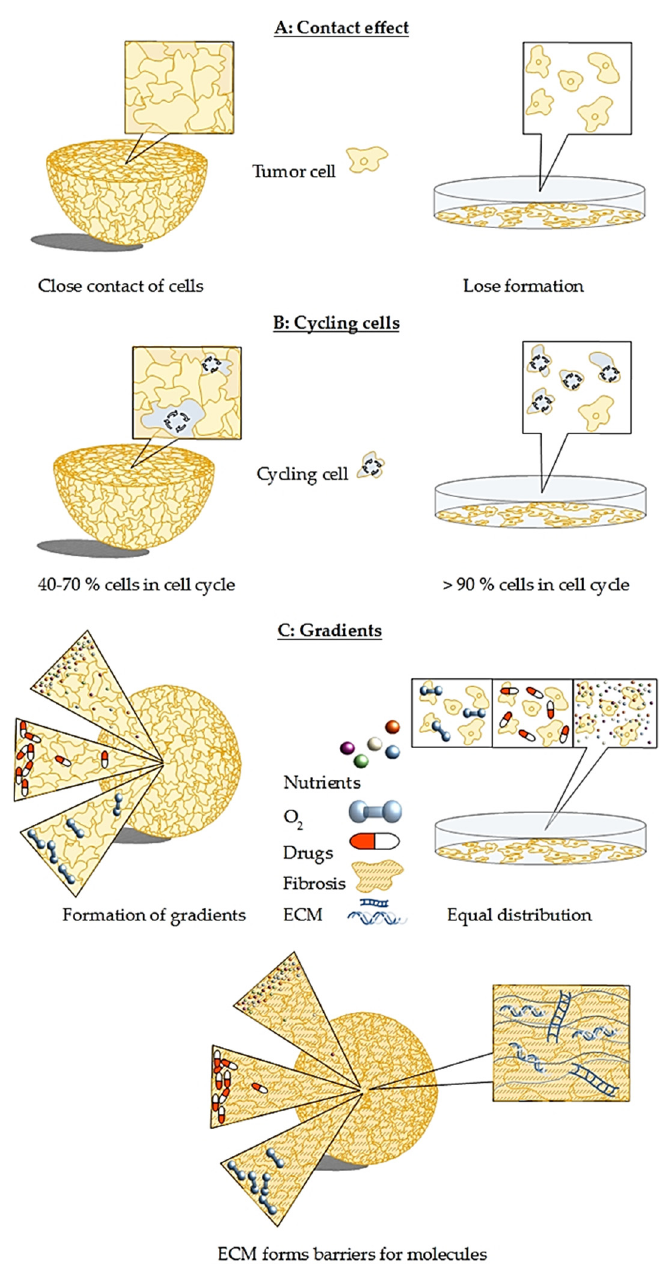
Figure 3. Major differences between spheroid and monolayer culture that cause challenges for therapy development: ( A ) in contrast to monolayer culture, cells in a spheroid are tightly packed. This leads to the contact effect that induces radioresistance observed in 3D models as well as in patients. ( B ) The percentage of cycling cells in spheroids is size-dependent and varies between 40 to 70%, while in monolayer culture, more than 90% of cells are cycling. That makes the monolayer cells much more prone to medication and leads to misleading results, explaining the high number of failed clinical trials. ( C ) Oxygen, nutrient, and drug gradients are present in spheroids with concentration and penetration of all three decreasing towards the spheroid core, whereas in a monolayer culture, oxygen, nutrients, and drugs can reach each cell with equal efficiency. This leads again to false expectations on the true effectiveness of a drug candidate. In PDAC, the situation is even more severe, as fibrosis leads to a dense mesh-like network that hampers nutrients, drugs, as well as oxygen from entering the spheroid, leading to pronounced gradient formation. All three challenges are present and even more complex in co-culture spheroids.